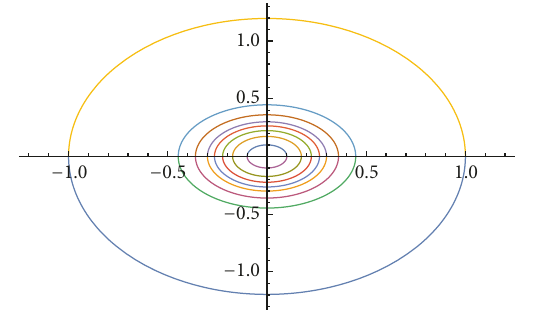
Figure 7: When 𝑐 = √2/2 , an invariant algebraic curve 𝑥 2 + (√2/2)𝑦 2 = 1 and seven small limit cycles.